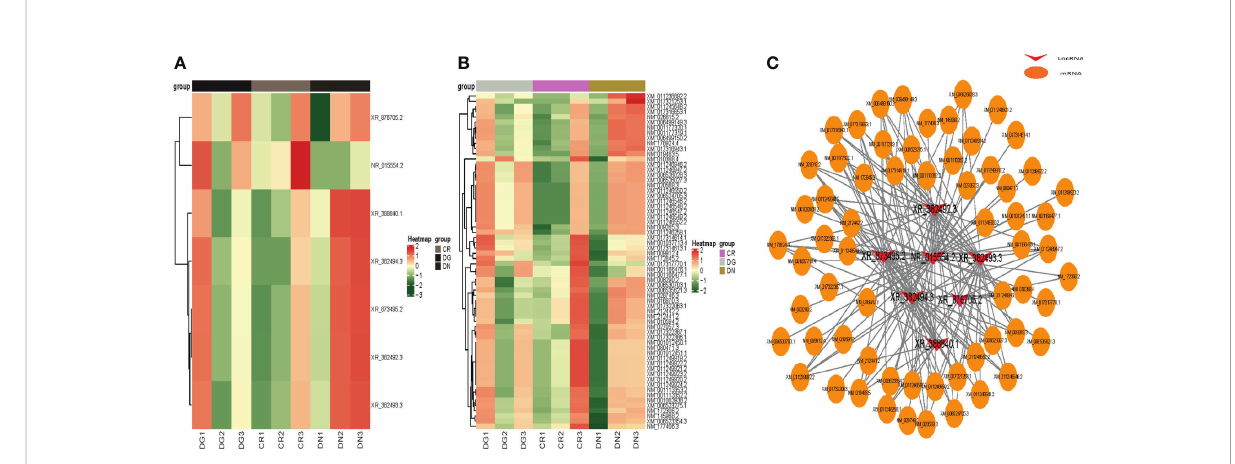
FIGURE 4 Co-expression network of LncRNA-mRNA. (A, B) Heatmap showing clustering analysis of differentially expressed LncRNAs (A) and mRNAs (B) in CR, DN and DG. (C) LncRNA-mRNA co-expression network in 7 LncRNAs and 63 mRNAs. CR, control group; DN, diabetic nephropathy group; DG, dapagli fl ozin